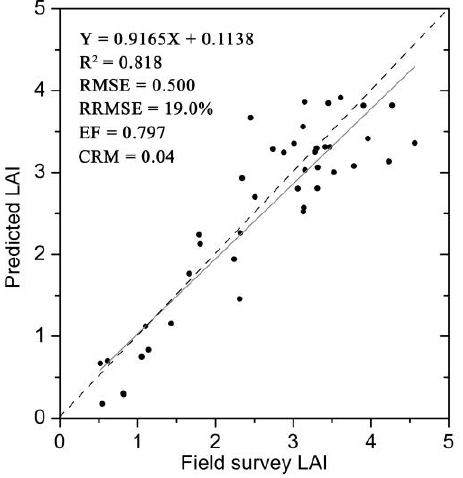
Figure 6. Scatter plots between field survey LAI and GF-1 WFV data predicated LAI.